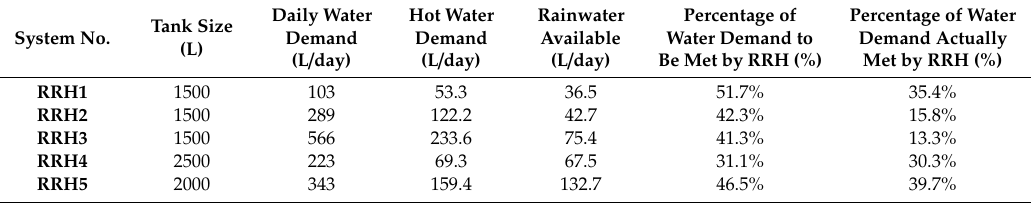
Table 4. Actual tank sizes and average water demand characteristics based on monitored data. System